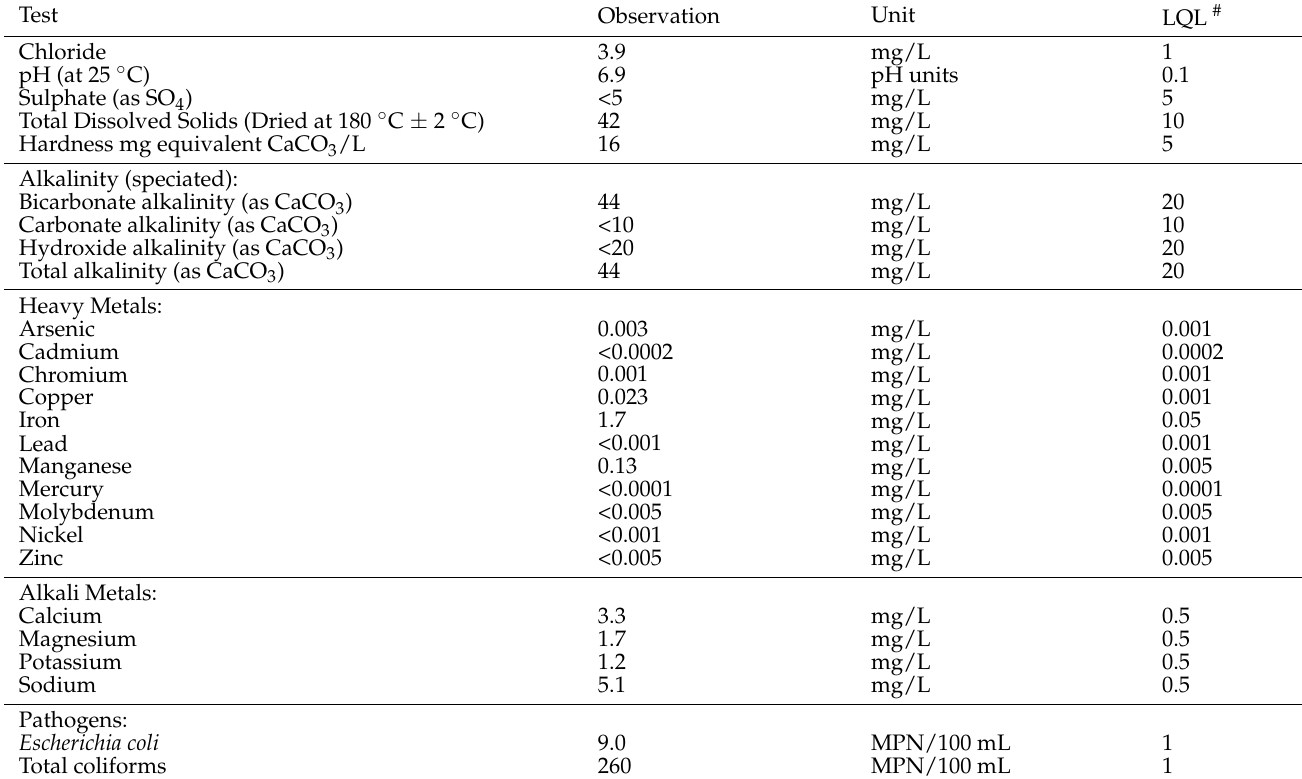
Table A1. Water quality analyses—Study 1a in Building A